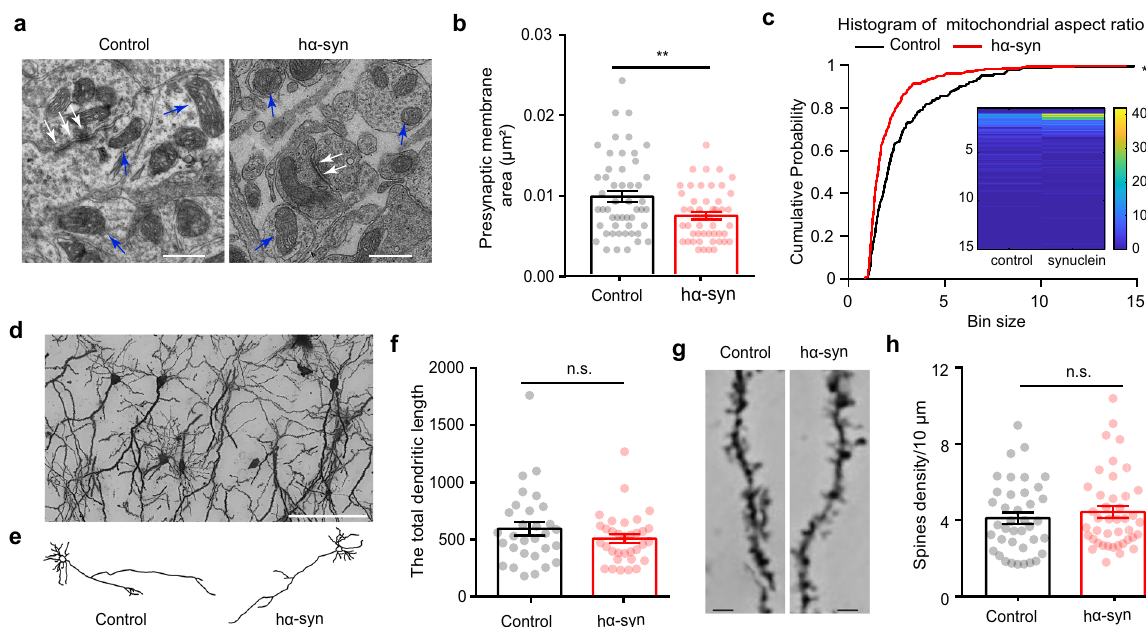
Fig. 8 Morphological changes induced by α -synuclein aggregation in the olfactory bulb. a Representative electron micrograph showing the synaptic ultrastructure (white arrows) and mitochondria (blue arrows) in neurons. Scale bars = 500 nm. b Quantitative analysis of the area of the presynaptic membrane in the two groups of mice (control: n = 51 synapses from 4 mice; h α -syn: n = 49 synapses from 4 mice). c Quantitative analysis of the mitochondrial aspect ratio (control: n = 231 mitochondria from 4 mice; h α -syn: n = 343 mitochondria from 4 mice). d Representative Golgi staining photomicrograph showing neurons in the granule cell layer of the OB. Scale bars = 20 μ m. e Representative reconstructions of granule cells from the OB of mice in the two groups. f Comparison of the total dendritic length of granule cells in the two groups of mice (control: n = 29 cells from 4 mice; h α -syn: n = 32 cells from 4 mice). g Representative dendrites and spines of granule cells obtained from control and h α -syn mice. Scale bars = 2 μ m. h Spine density on granule-cell dendrites (control: n = 39 dendrites from 3 mice; h α -syn: n = 42 dendrites from 3 mice). ** p < 0.01; *** p < 0.001; n.s. not signi fi cant. Data are presented as mean ±